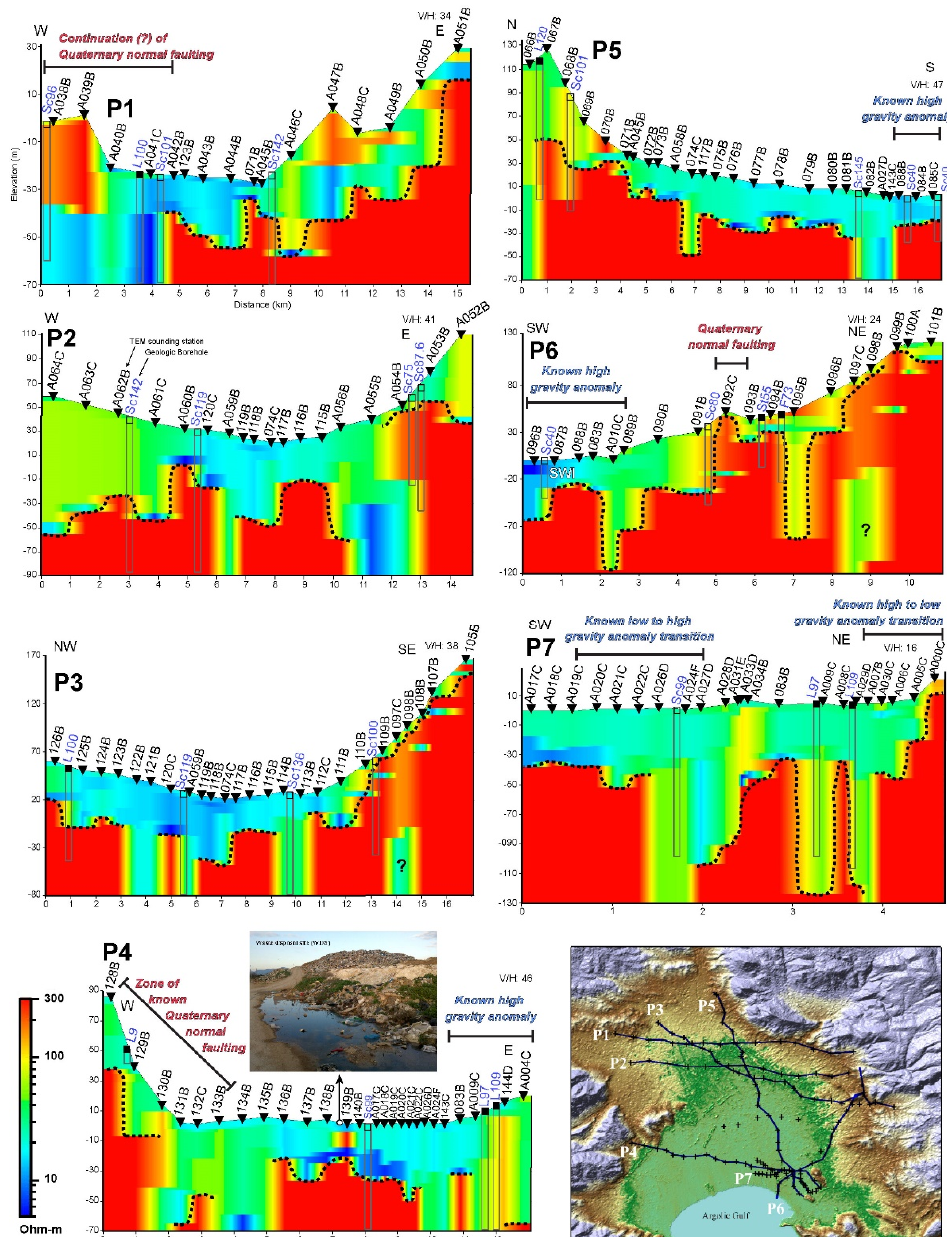
Figure 7. Map of the Argive Basin (lower right) showing the distribution of the quasi-2D electrical resistivity profiles (blue lines) across the basin. The higher resistivity anomalies (300 Ω -m) shown in all profiles represent the interpreted bedrock formation. The lower resistivity anomalies in tones of blue to yellow represent the thick and irregular Late Neogene–Quaternary heterolithic clastic deposits. The geologic interface between the heterolithic sedimentary cover and the weathered and fractured bedrock is traced across all quasi-2D resistivity profiles. The lower resistivity anomalies within the interpreted bedrock formation represent sub-vertical-to-vertical structural geologic discontinuities (e.g., fracture zones, faults, or patches of highly-weathered rock). It should be mentioned that during the inversion and final interpretation of the resulted quasi-2D sections, blocky structures such as the one shown in P4 beneath the WDS can appear as artifacts [type H (p1 > p2 < p3) curve where the resistivity of the middle layer (leachates with a resistivity less than 1 Ω -m) is less than 20 times the resistivity of the layer above and below (~300 Ω -m), Reynolds [52]. For example, the resistivity anomaly in the SW end of Profile P6 corresponds to a saline water intrusion (SWI). All quasi-2D resistivity profiles have vertical exaggeration shown by the label V/H.